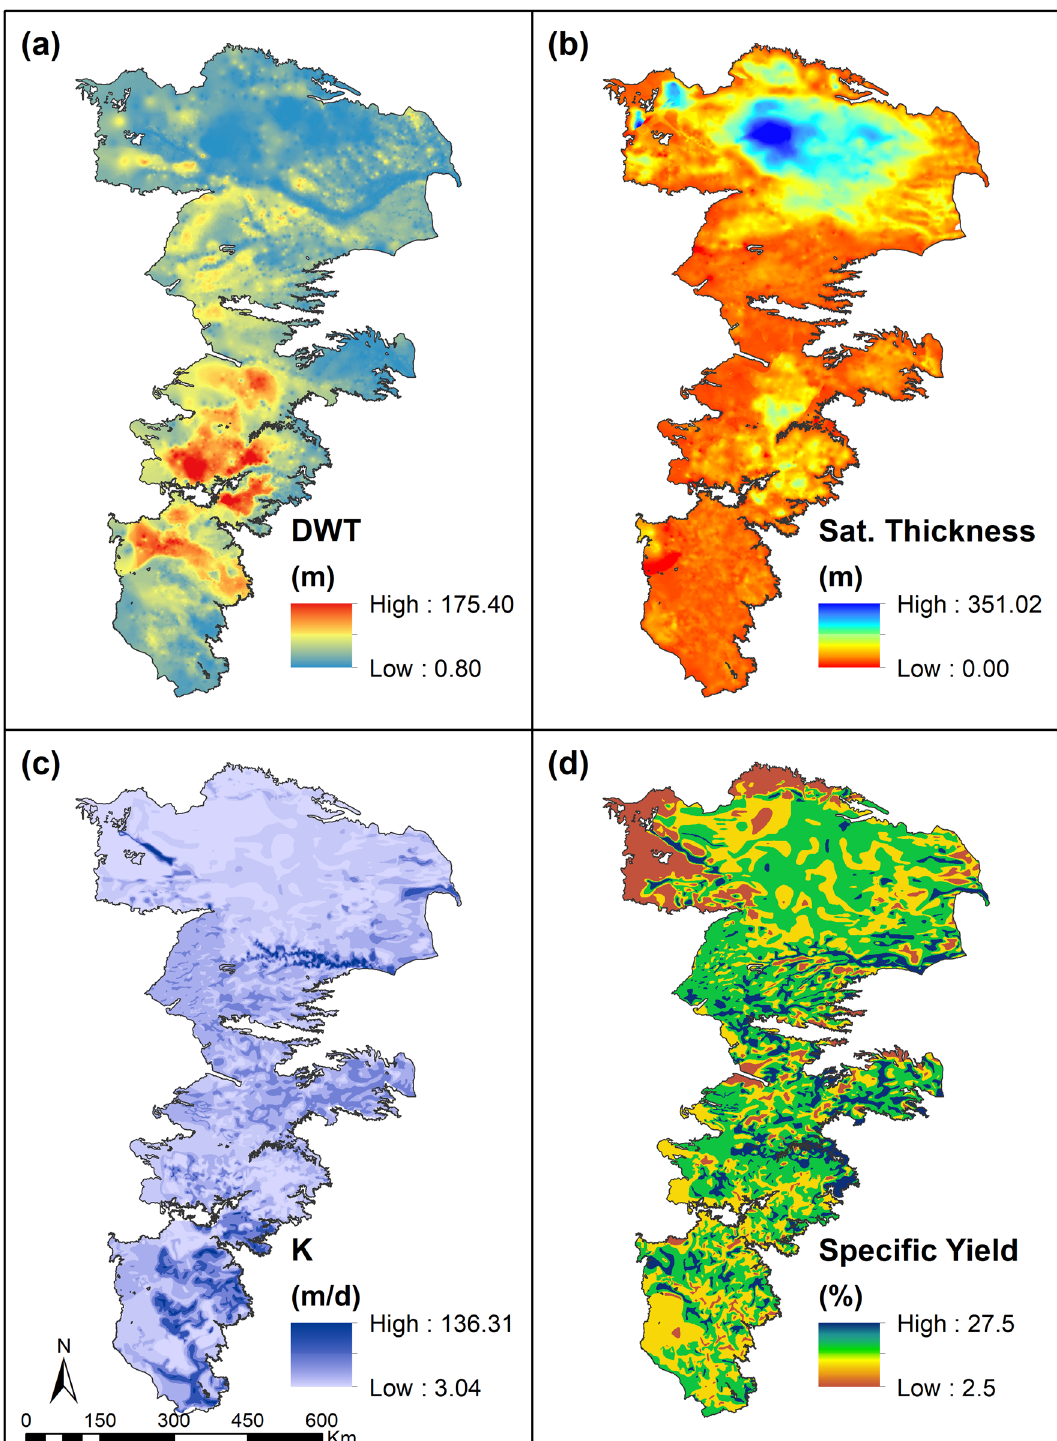
Figure 10. Groundwater characteristics in the study area (Data Compiled from US Geological Survey 57,68–70